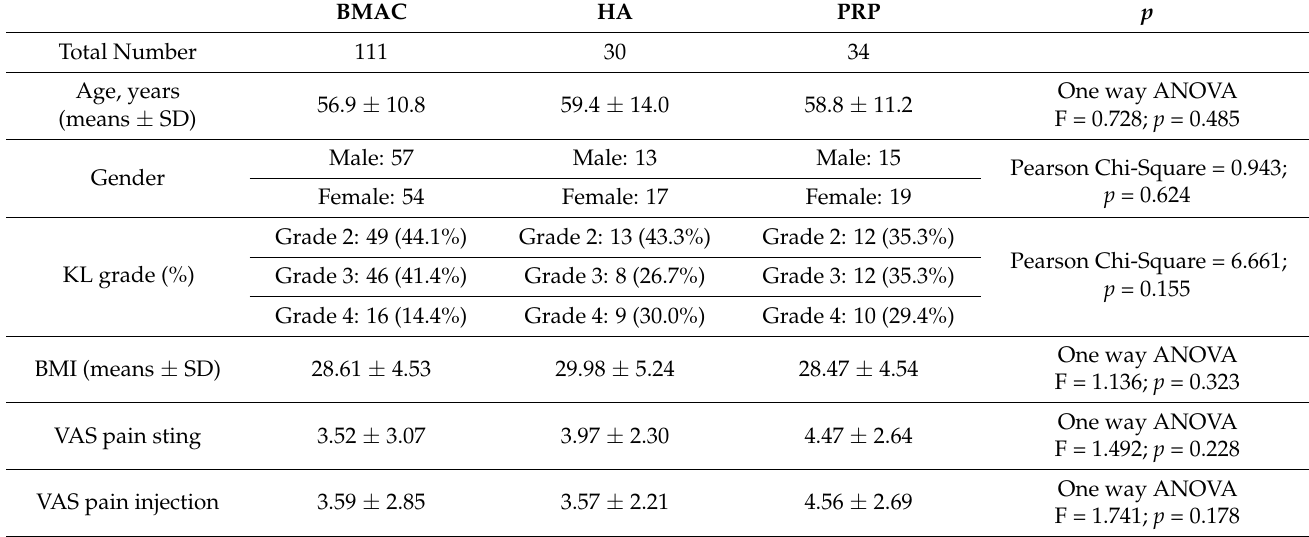
Table 1. Patients characteristics for all intervention groups.